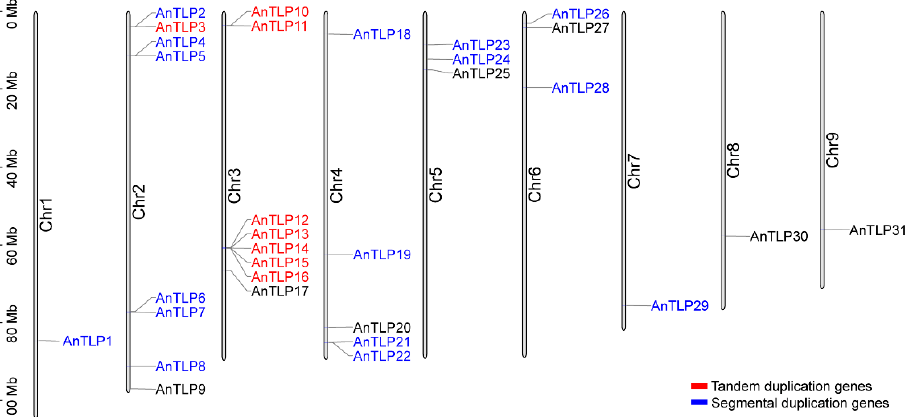
Figure 1. The distribution of AnTLP genes in the chromosomes of A. nanus . Different colors repre- sented gene replication type. Blue represented fragment replication, and red represented tandem replication. Table 1. Characterization of the predicted TLPs in A. nanus.